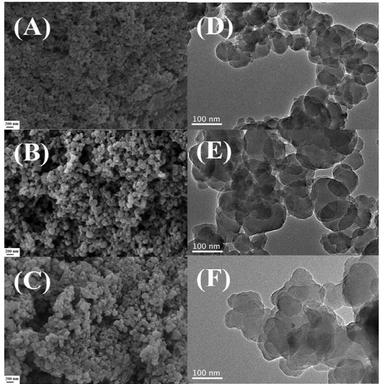
SEM (A − C) and TEM images (D − F) of PPy-1 (A, D), PPy-2 (B, E) and PPy-3 (C, F).